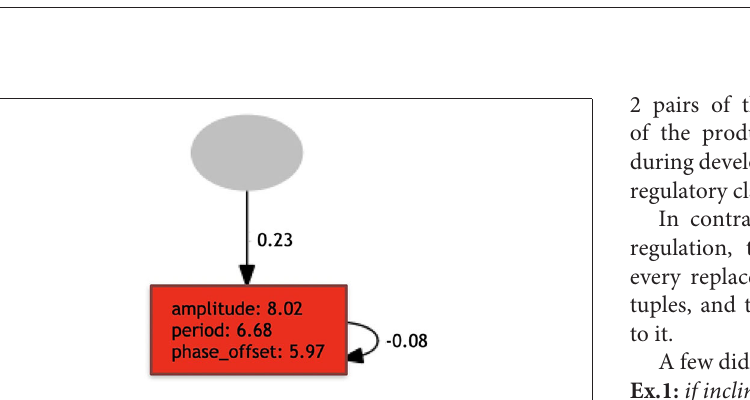
FIGURE 3 | (Top) Effects of environmental regulation on phenotype. (Bottom) Effect of the environment on the evolutionary process of the